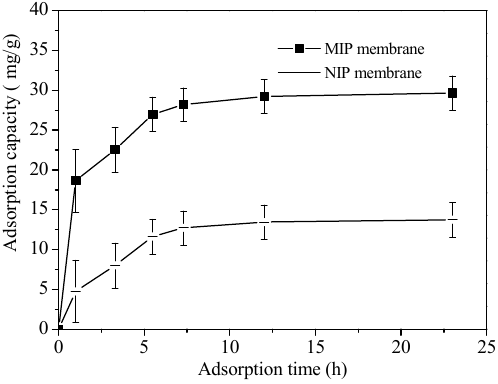
Figure 7. Adsorption dynamics of BSA on MIP and NIP membrane.